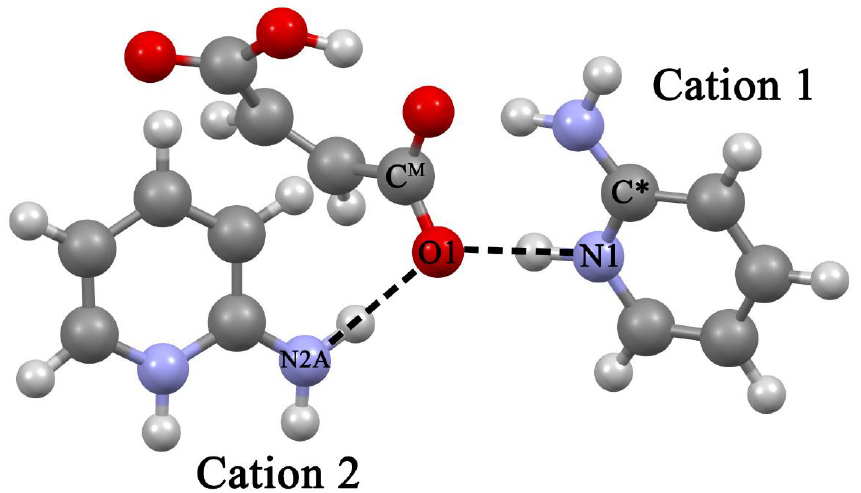
Figure 4. A fragment of the [2AmPyr + Mle] (1:1) crystal structure. Black dotted lines indicate the O1 ··· N1 and O1 ··· N2A distances.